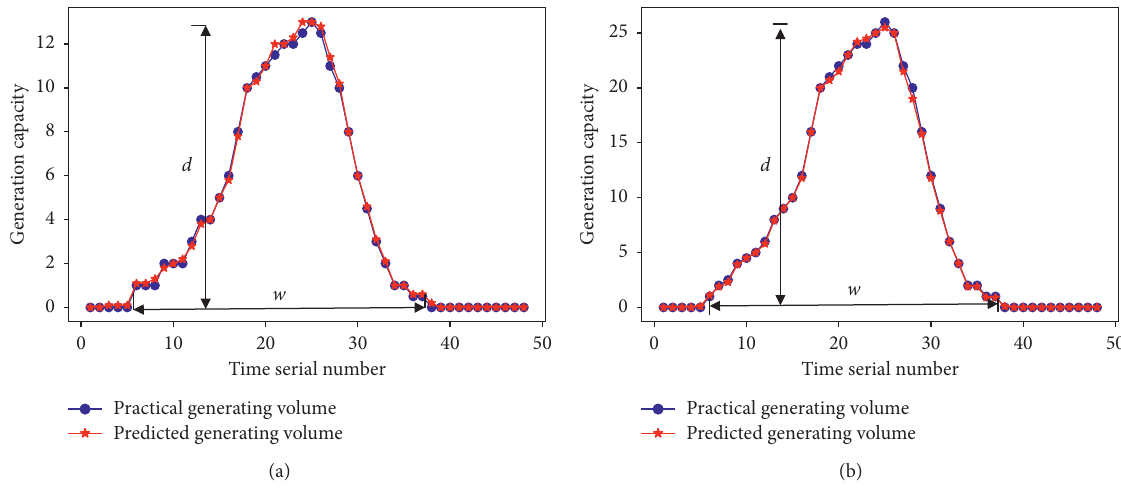
Figure 5: Power generation forecast of two days in winter. (a) Comparison between predicted curve and real value of power generation on January 3. (b) Comparison between predicted curve and real value of power generation on January 4. Note: w represents the time zone of daily effective generation and d represents the peak value of daily generation.